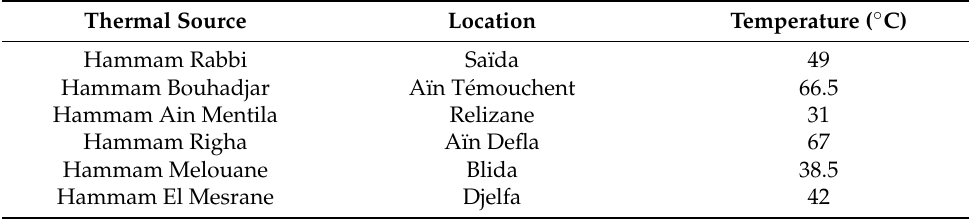
Table 2. Thermal source locations in